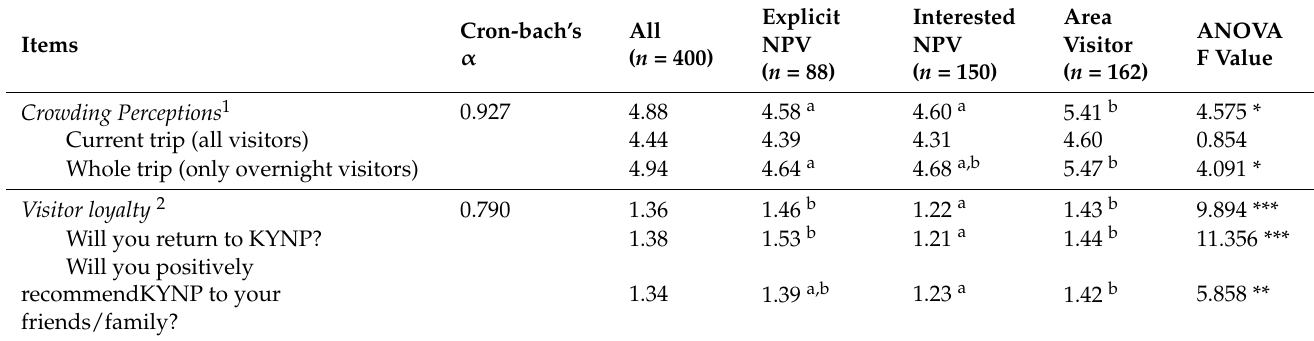
Table 5. Perceptions of recreation quality and visitor loyalty per national park affinity